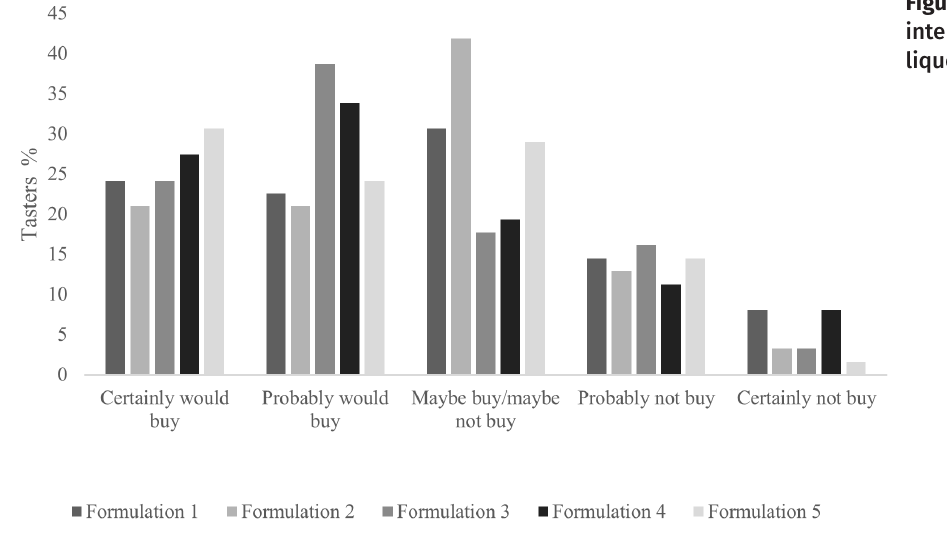
Figure 3. Buying intention for the liqueur